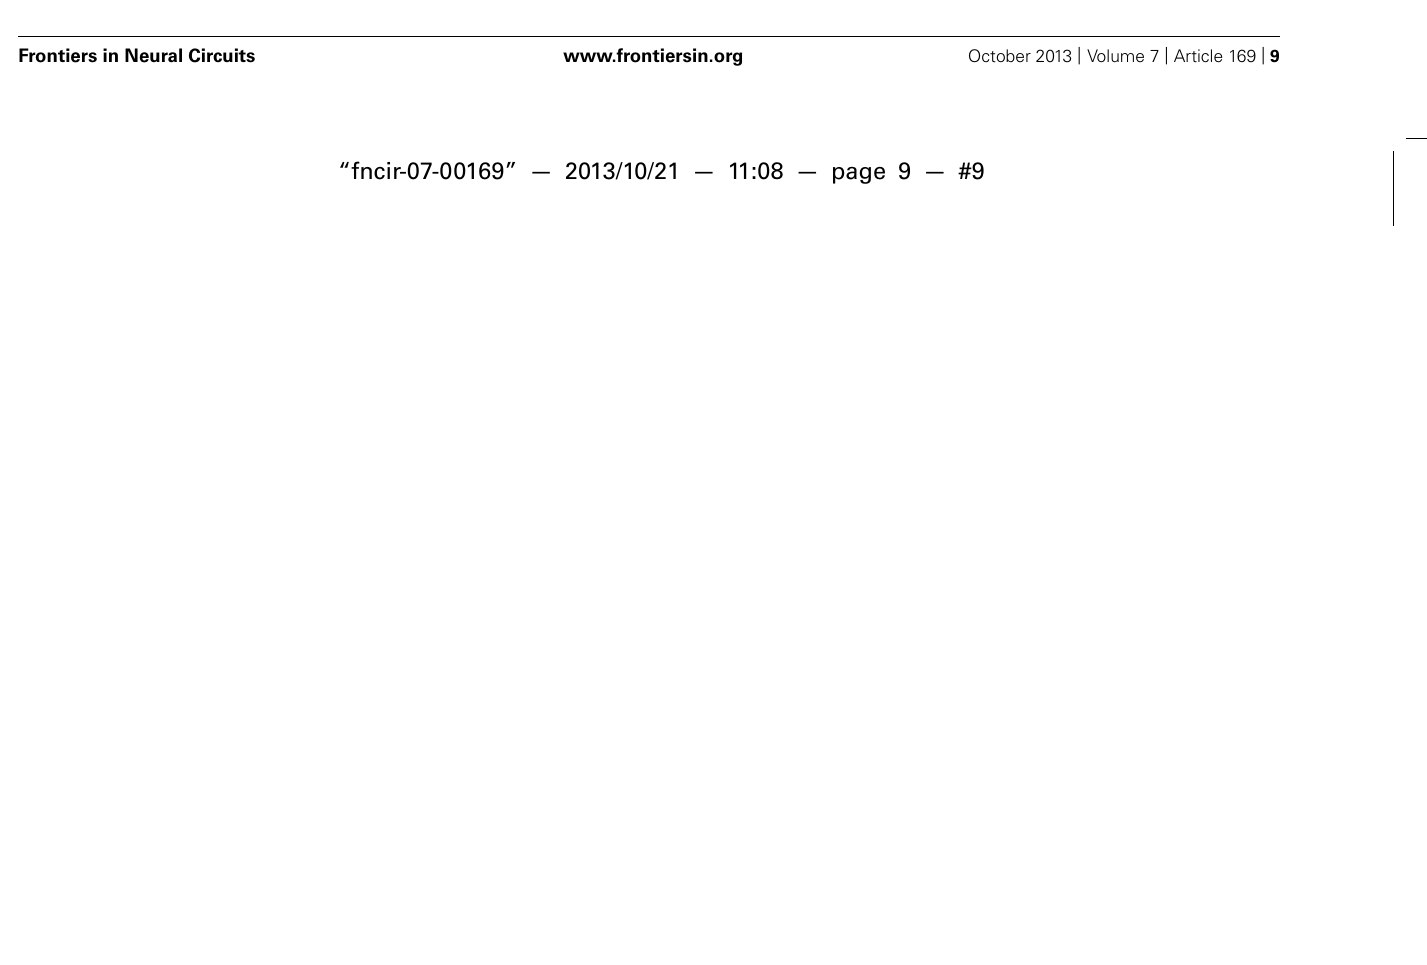
FIGURE 6 | Spike activity influences the LP I A : I h ratio in 5 μ M DA. (A,B) Diagrams of recurrent voltage steps that were applied during 5 μ M DA application. Spikes are not drawn to scale. Note the recurrent step mimicked the DA-induced decrease in LP burst duration and cycle period. In addition, it mimicked spike activity. In (A) , spike activity is represented as a single depolarizing step to + 40 mV.The duration of the step = 6 spikes × 2 ms = 12 ms. In (B) , the six spikes are represented as 6, 2 ms depolarizations to + 40 mV.The time between each depolarization is 0.66 x average ISI in ms at t = − 10 min. (C) Plot of the fold-changes in the LP I A : I h ratio (mean ± SEM) throughout a 1 h superfusion with 5 μ M DA and implementation of the recurrent voltage step indicated by protocol A.The ratio significantly decreased with time; * p < 0.05, repeated measures ANOVA with Dunnett’s post hoc tests that compare all time points to t = 0 (see text). (D) Plots of the